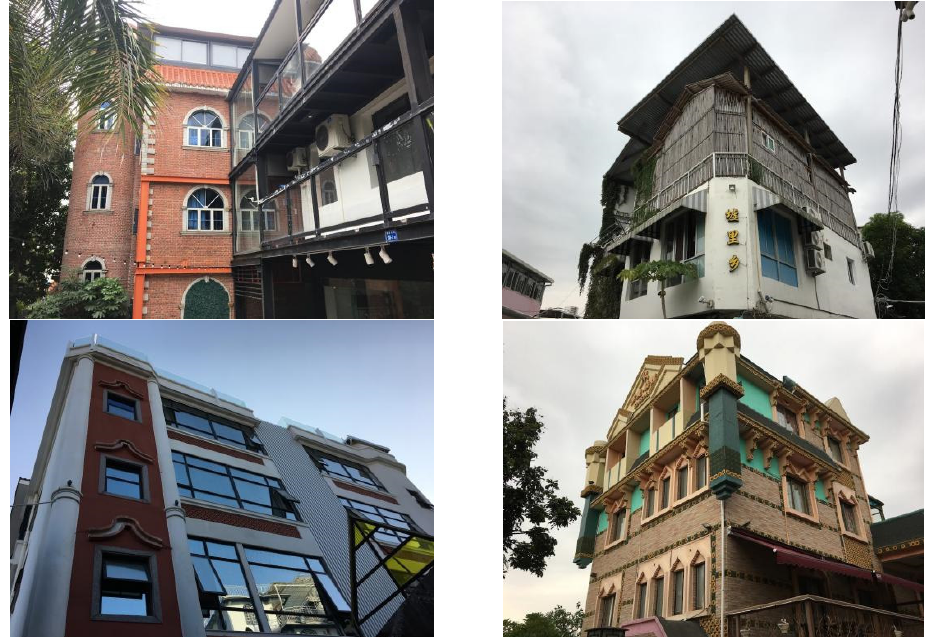
Figure 7. Diversified hotel styles in Zengcuoan Source: Photo by the authors.